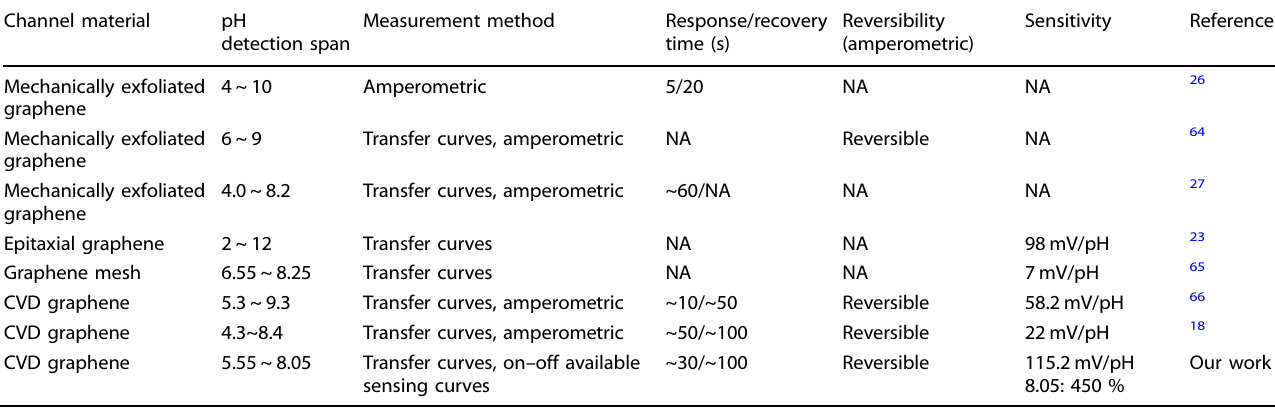
Table 1. Comparison of other graphene-based pH